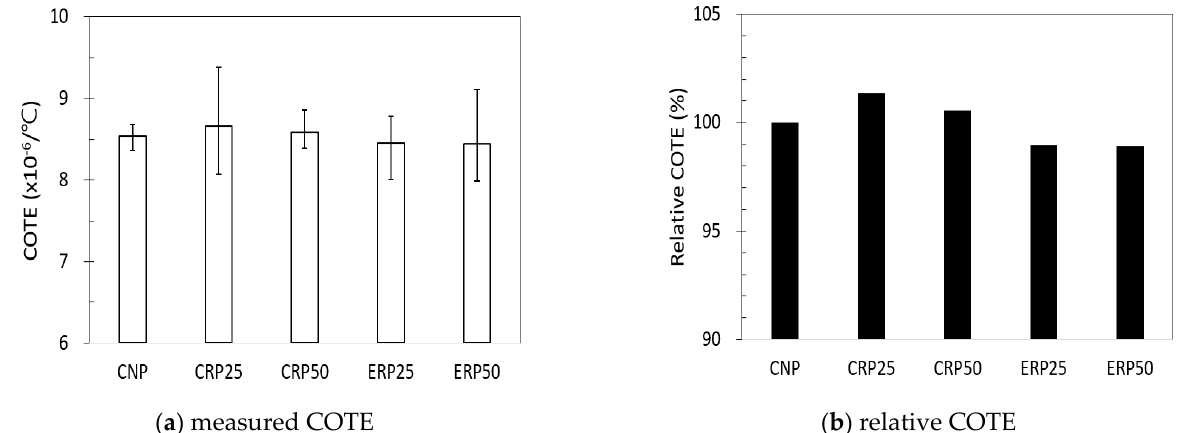
Figure 6. COTE and relative values in test series 2.